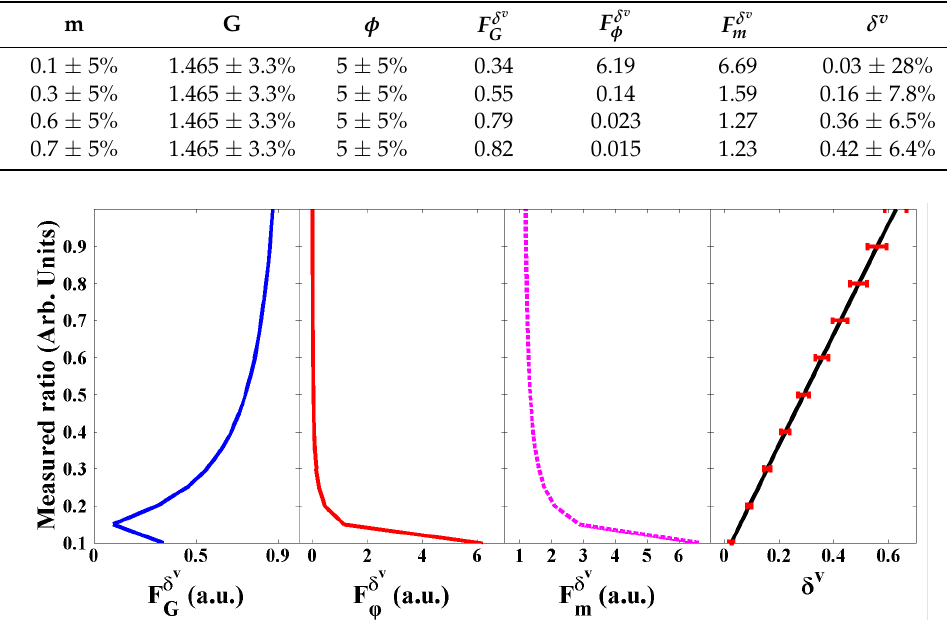
Table 2. Error of volume depolarization ratio propagated from the errors in the gain ratio, the measured ratio and the rotation angle of the plane of polarization. Note that the error of the measured ratio m , depends on measurements. The value 5% is only used for instance in this table. It is variable in routine measurements.